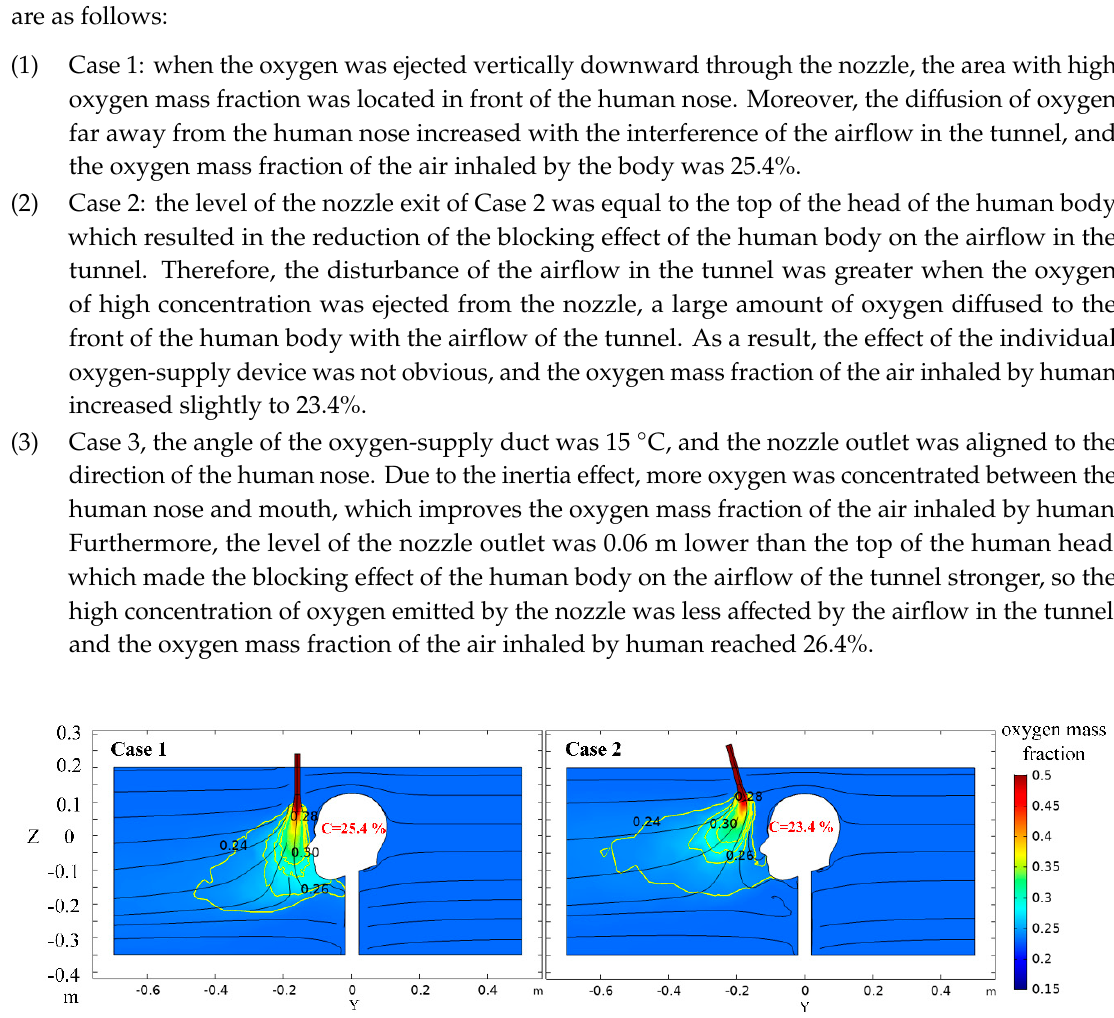
Figure 5. Distribution of oxygen mass fraction in the X = 0 m section.